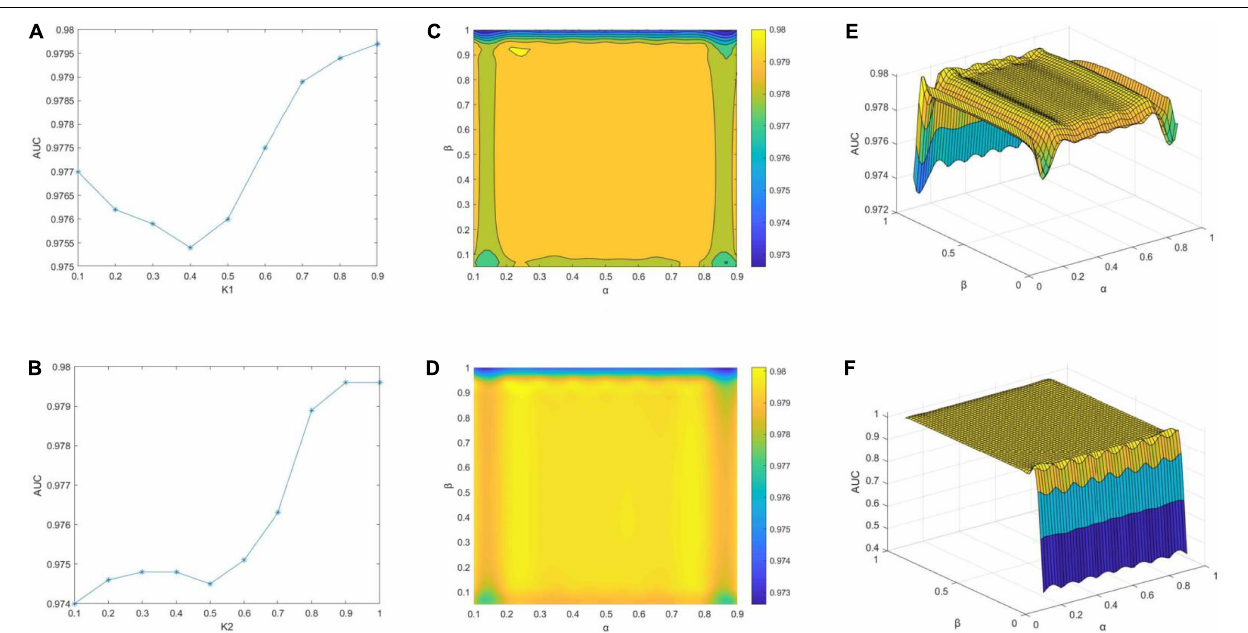
FIGURE 3 | Impact of parameters on AUC scores of MILNP. (A) Effect of K 1 when fixing K 2 , α and β . (B) Effect of K 2 when fixing K 1 , α and β . (C–F) Effect of α and β when fixing K 1 and K 2 .